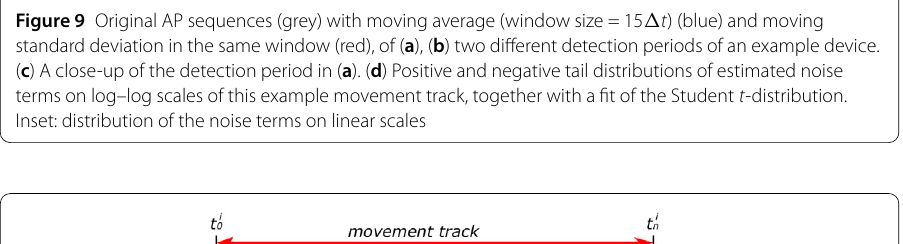
Figure 9 Original AP sequences (grey) with moving average (window size = 15 (cid:2) t ) (blue) and moving standard deviation in the same window (red), of ( a ), ( b ) two different detection periods of an example device.